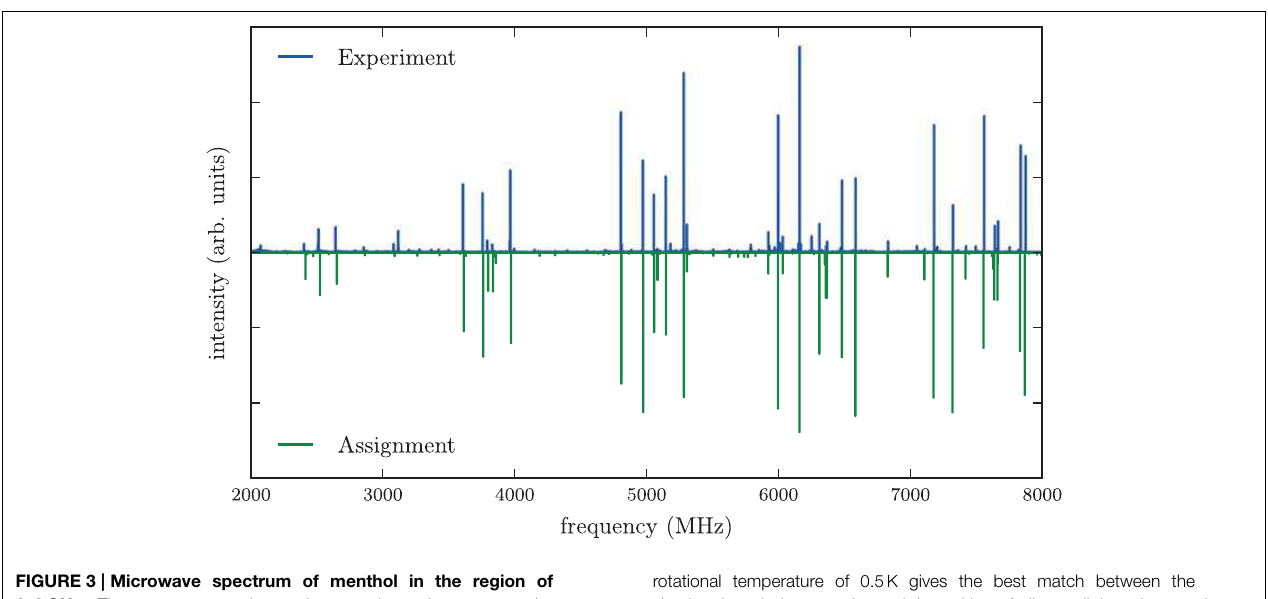
rotational temperature of 0 . 5K gives the best match between the simulated and the experimental intensities. A line splitting due to the internal rotation of any of the methyl groups is not observed in the spectrum.